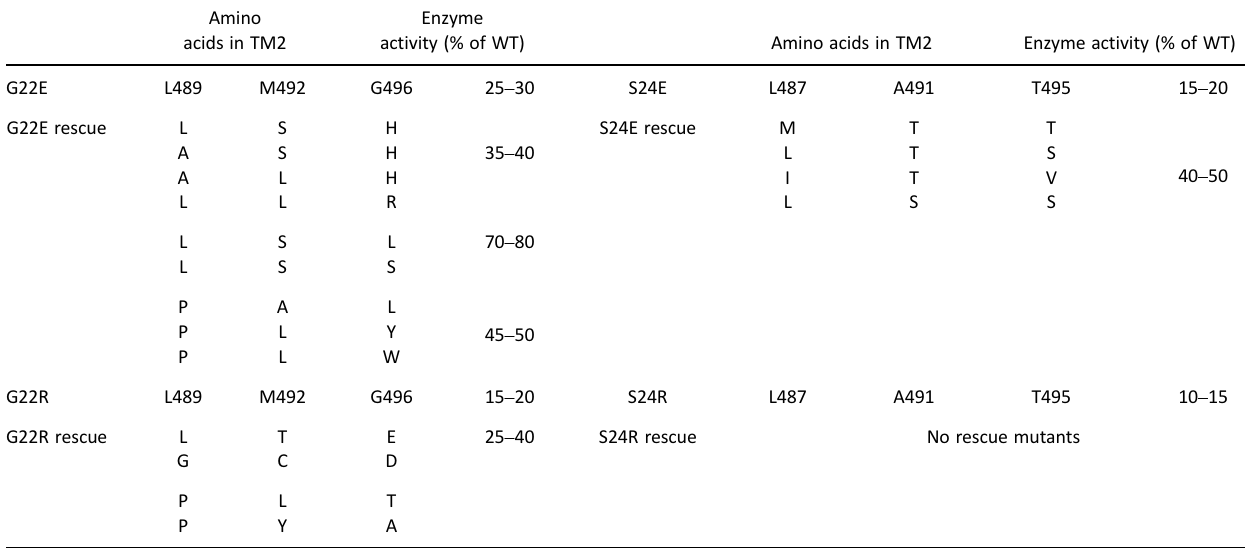
Table 3 . The rescue of glutamic acid or arginine mutants in the TM1 with the mutations in the TM2 of CD39 Amino Enzyme acids in TM2 activity (% of WT)